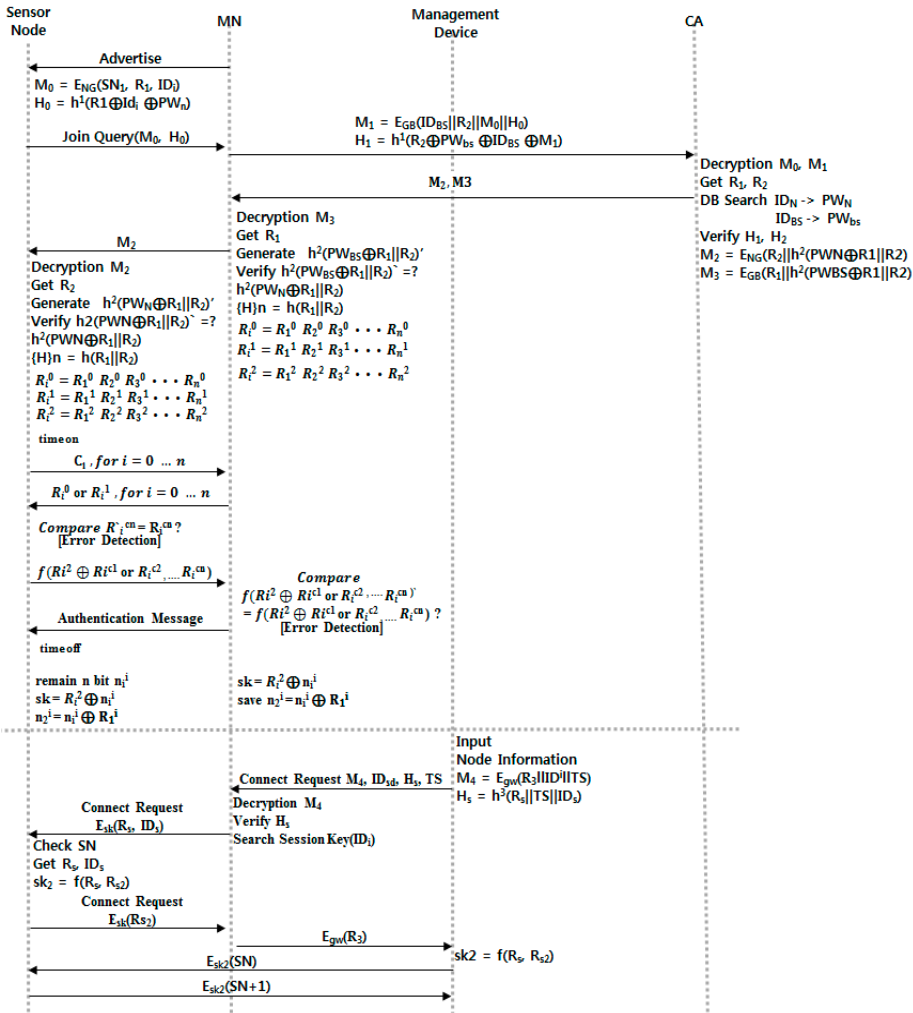
Figure 5. Initial authentication and device registration process.